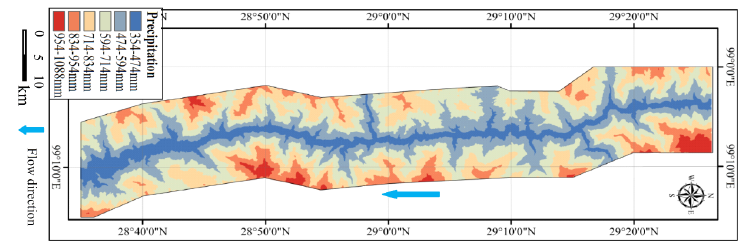
Figure 8. The annual precipitation classification of the study area.